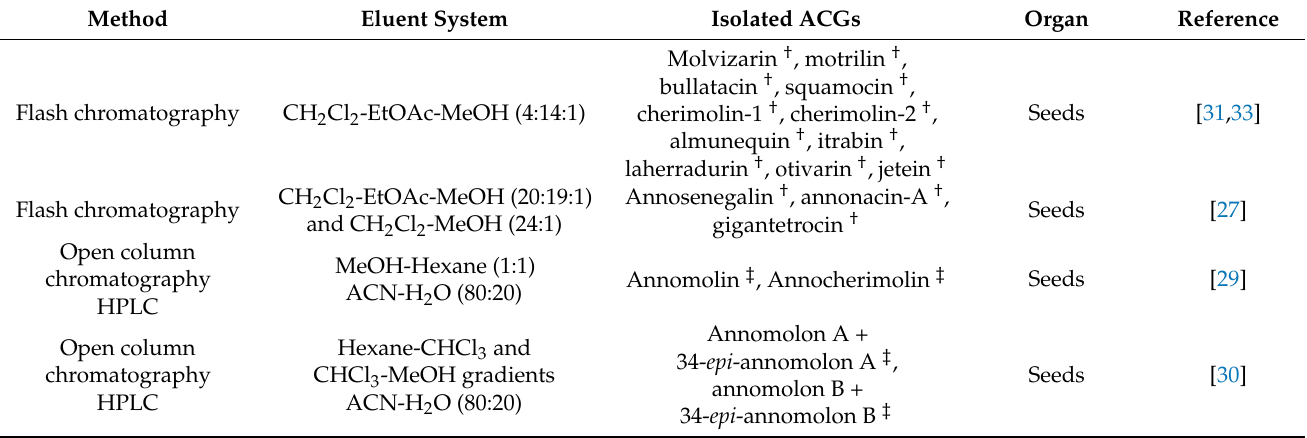
Table 2. ACGs isolated from A. cherimola